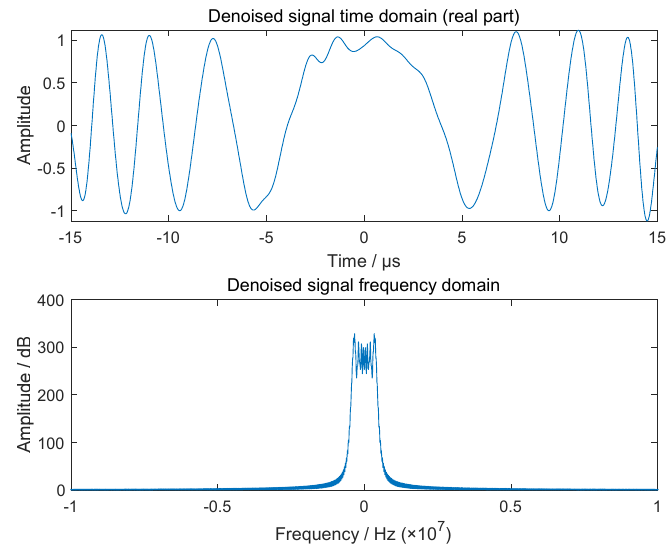
Figure 4. Time domain and frequency domain diagram of de–noised signal.